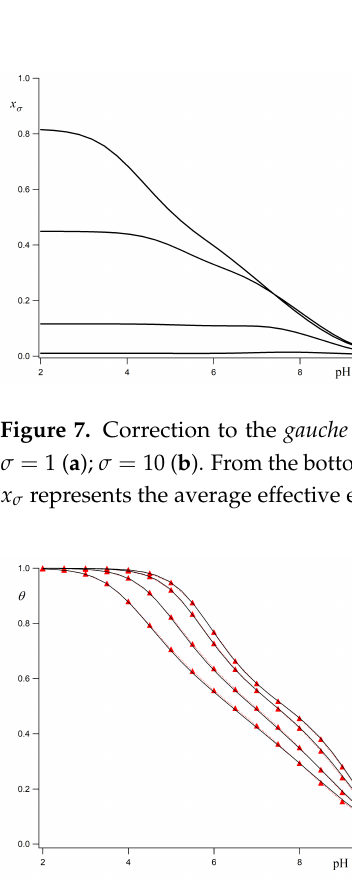
Figure 8. Titration curves ( a ) and gauche state probabilities ( b ) obtained using the LEIP method (black lines) and MC simulations (red markers). The chosen parameters are p K = 9, (cid:101) t = 1, (cid:101) g = 2 and σ = 1. ( a ) the ionic strength are, from top to bottom, 1 M, 0.1 M, 0.01 M and 0.001 M; ( b ) three different ionic strengths are shown: I = 1 M (circles and continuous line), 0.01 M (squares and dotted line) and 0.001 M (triangles and dashed